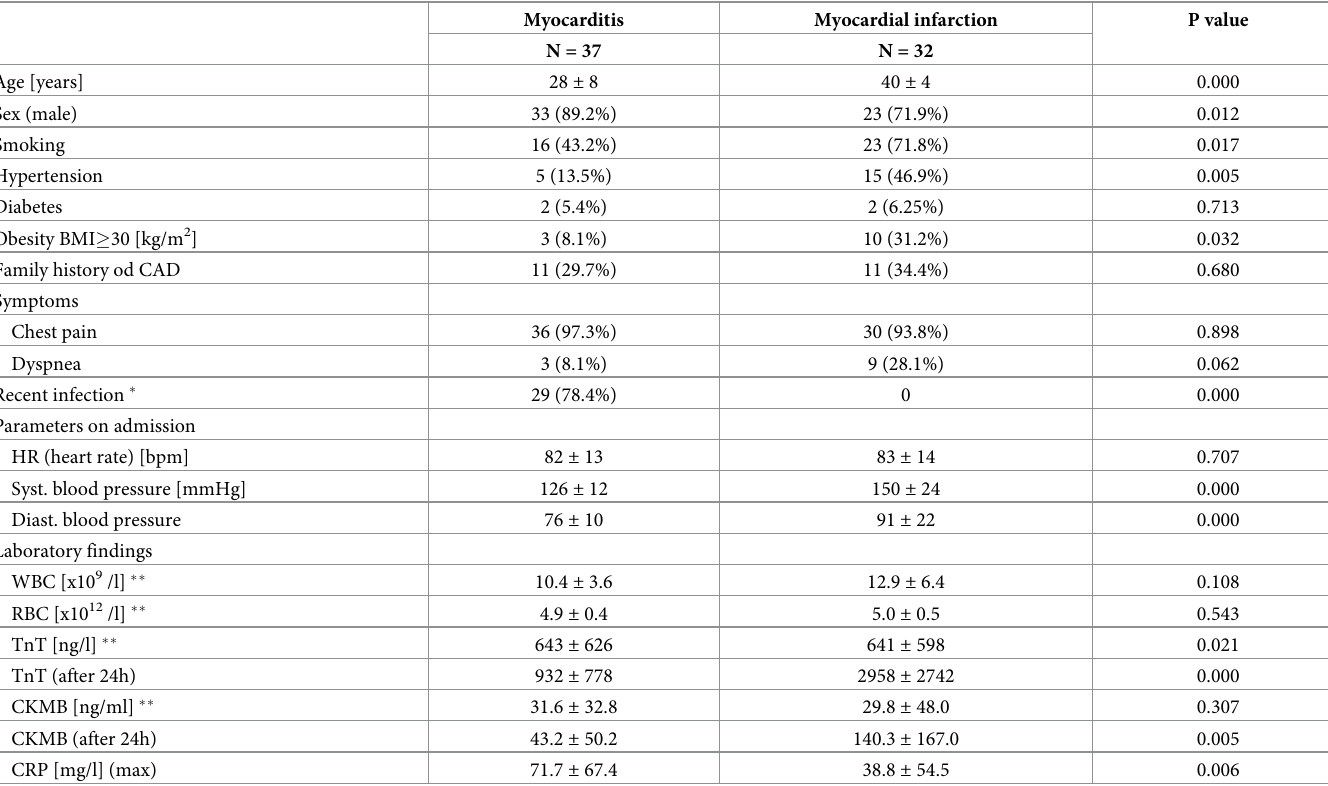
Table 1. Baseline